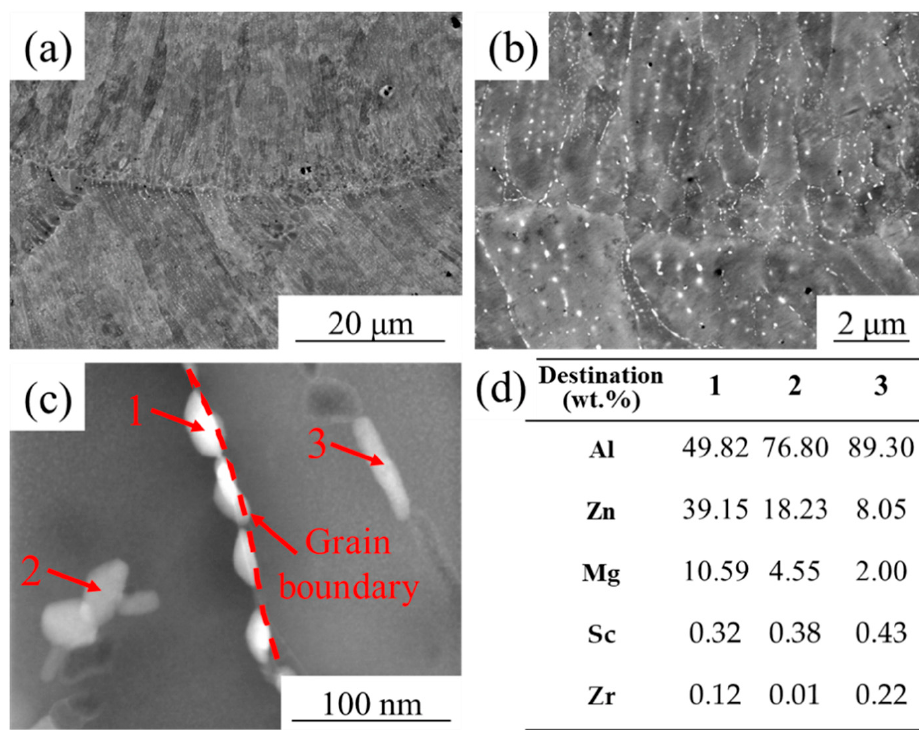
Figure 7. ( a ) the ECC photo of sample 4 in the as-printed status, ×2000, ( b ) the ECC photo of sample 4 in the as-printed status, ×10000, ( c ) TEM photo of sample 4 in as-printed status, ( d ) the EDS analysis of ( c ).